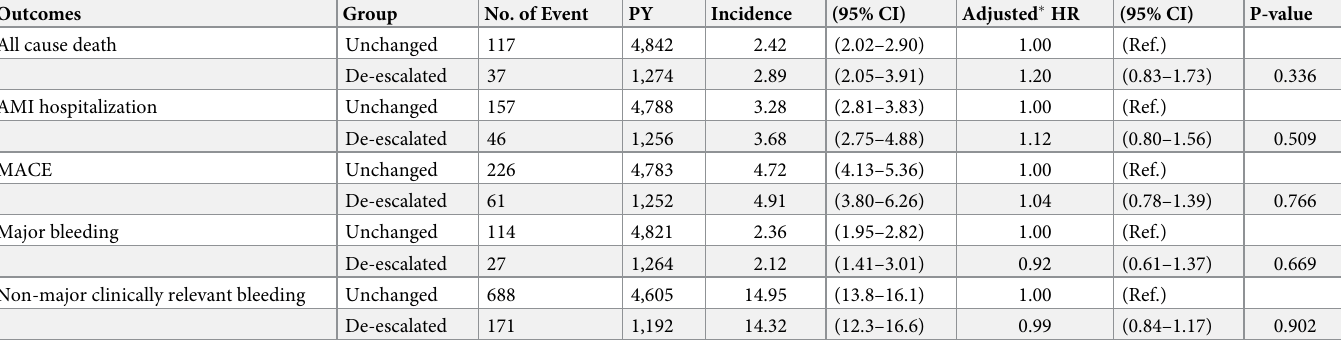
Table 2. The incidence (per 100 PY) and adjusted HR of major vascular and bleeding events in unchanged and de-escalated DAPT group during one-year follow- up.